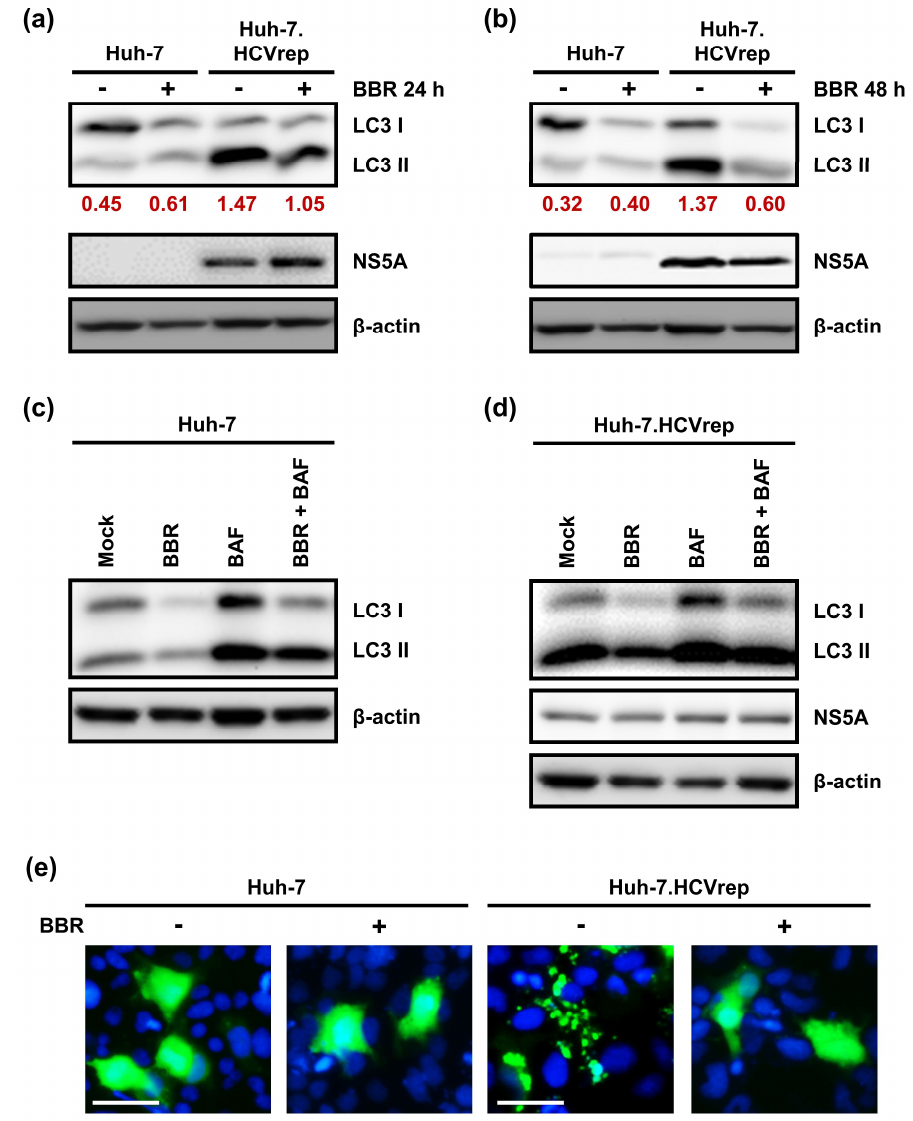
Figure 4 Figure 4. Berberine (BBR) modulated autophagy in the hepatoma cells. Huh-7 and Huh-7.HCVrep cells were seeded in six-well plates and treated with or without 100 µ M BBR for ( a ) 24 or ( b ) 48 h. The lysates were collected at the end of the incubation periods for a Western blot analysis against microtubule-associated protein 1 light chain 3 (LC3). Densitometry was calculated by normalization of LC3II expressions to β -actin. ( c ) Huh-7 and ( d ) Huh-7.HCVrep cells seeded in six-well plates were treated either with BBR alone, bafilomycin A1 (BAF) alone, or pretreated with BAF for 4 h before treating with BBR for an additional 24 h. The whole cell lysates were collected and analyzed by Western blotting. For all Western blot analyses, nonstructural protein 5A (NS5A) expression indicated the presence of hepatitis C virus (HCV) replicon, and β -actin was used as a loading control. ( e ) Huh-7 and Huh-7.HCVrep cells that were seeded in 24-well plates were transfected with the enhanced green fluorescent protein (EGFP)-LC3 plasmid overnight and treated with or without BBR for 48 h. The cells were then fixed, stained with the Hoechst nuclear stain, and then viewed using a fluorescence microscope. Magnification = 200 × ; scale bar = 40 µ